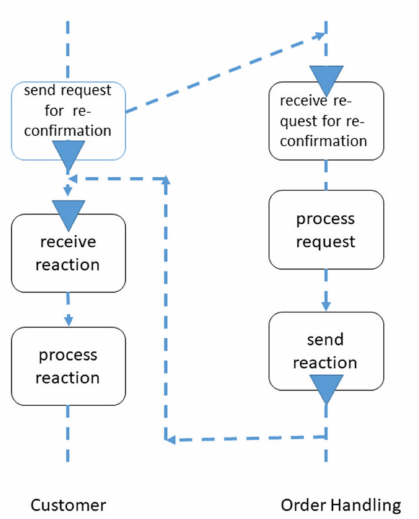
Figure 10. Subject-oriented representation tested interactively (using the Metasonic Suite— metasonic.de).